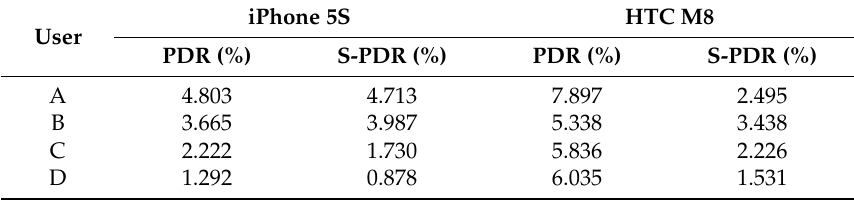
Figure 15. The trajectories of four participants using an HTC. Table 10. The percentage of loop closure error of four participants using two